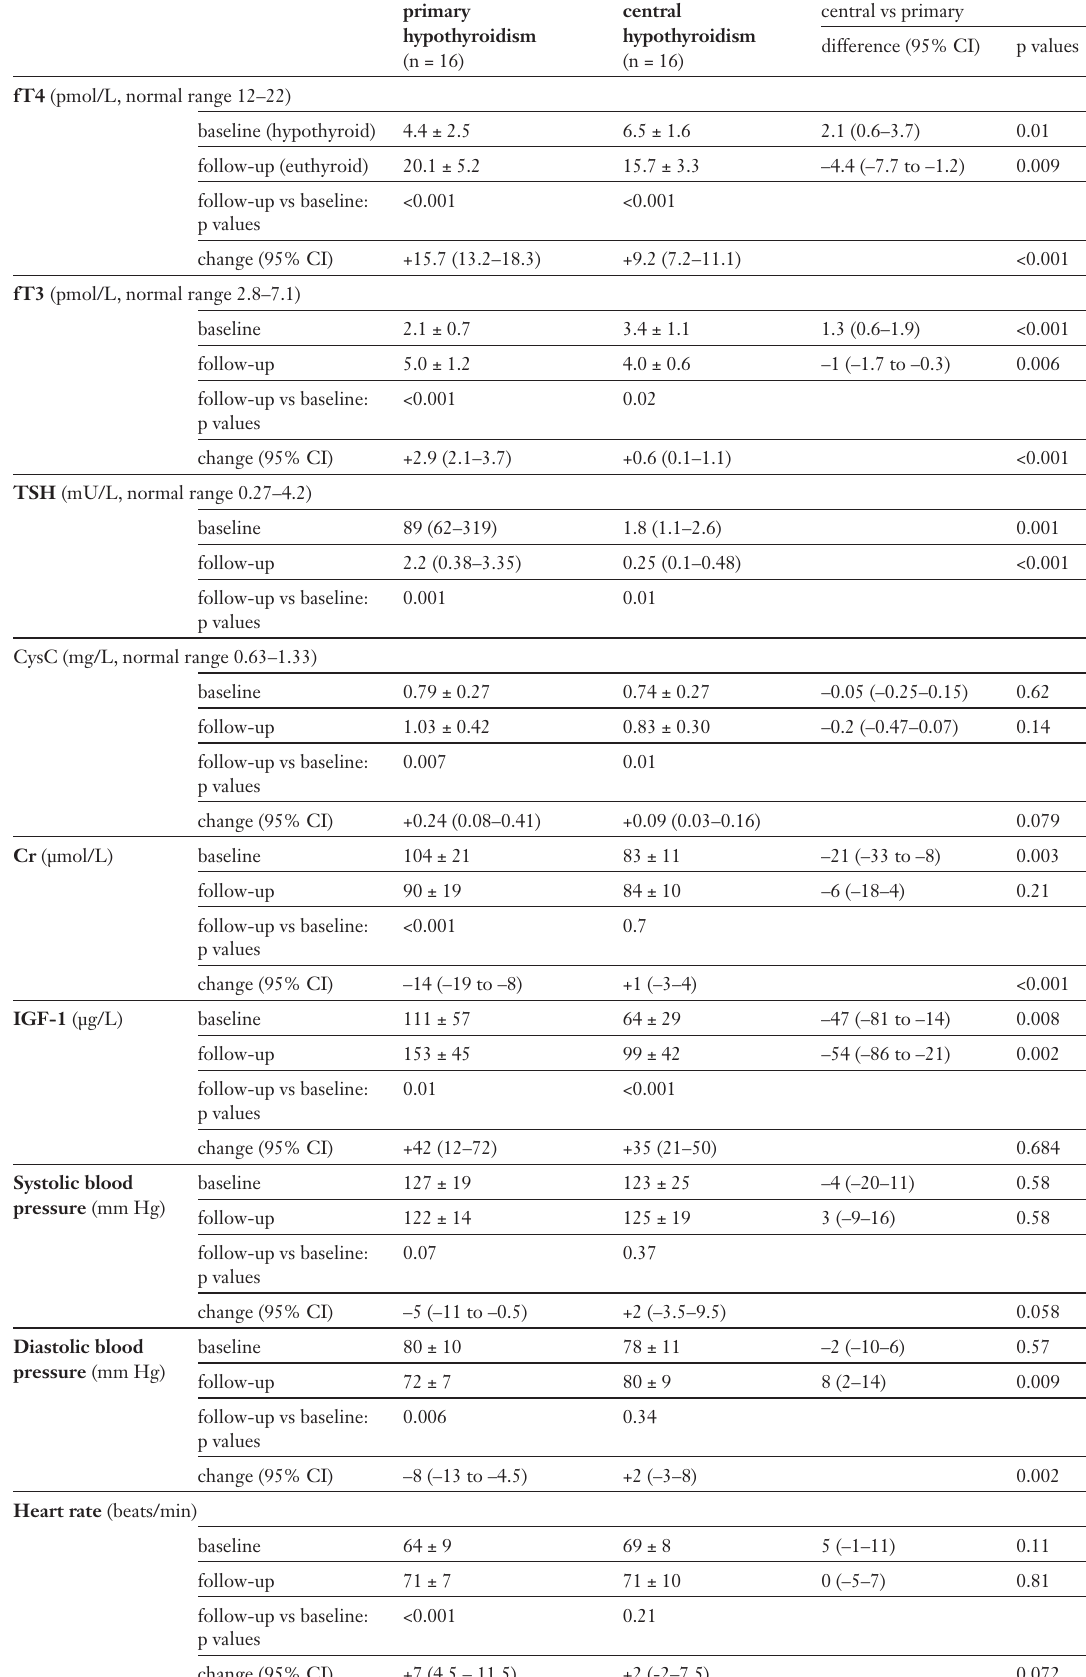
Response toT4 replacement